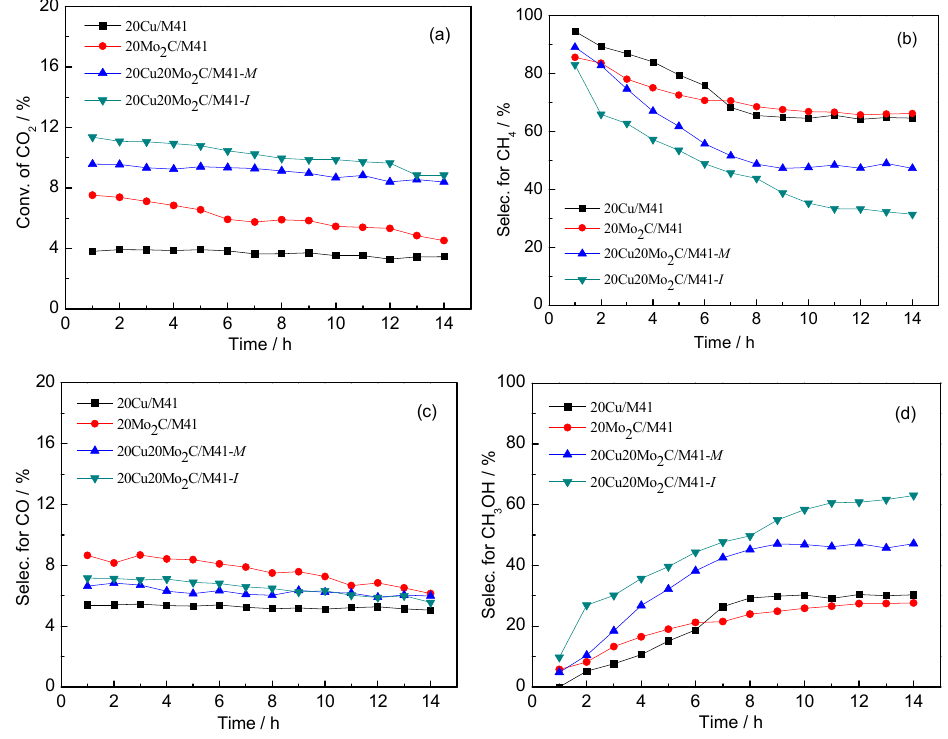
Figure 6. Catalytic performance of 20Cu20Mo 2 C/M41 with different introducing method of Cu promoter in CO 2 hydrogenation. ( a ) CO 2 conversion; ( b ) CH 4 selectivity; ( c ) CO selectivity; ( d ) CH 3 OH selectivity. Reaction conditions: catalyst 0.5 g, temperature 493 K, pressure 3.0 MPa (H 2 :CO 2 = 3:1), GHSV 3600 mL/(h ∙ g).